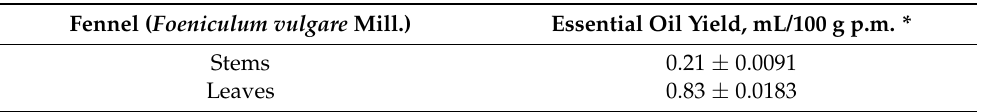
Table 1. Yields of essential oil from the stems and leaves of wild-grown fennel obtained after 120 min of hydrodistillation (hydromodule 1:10 m / v